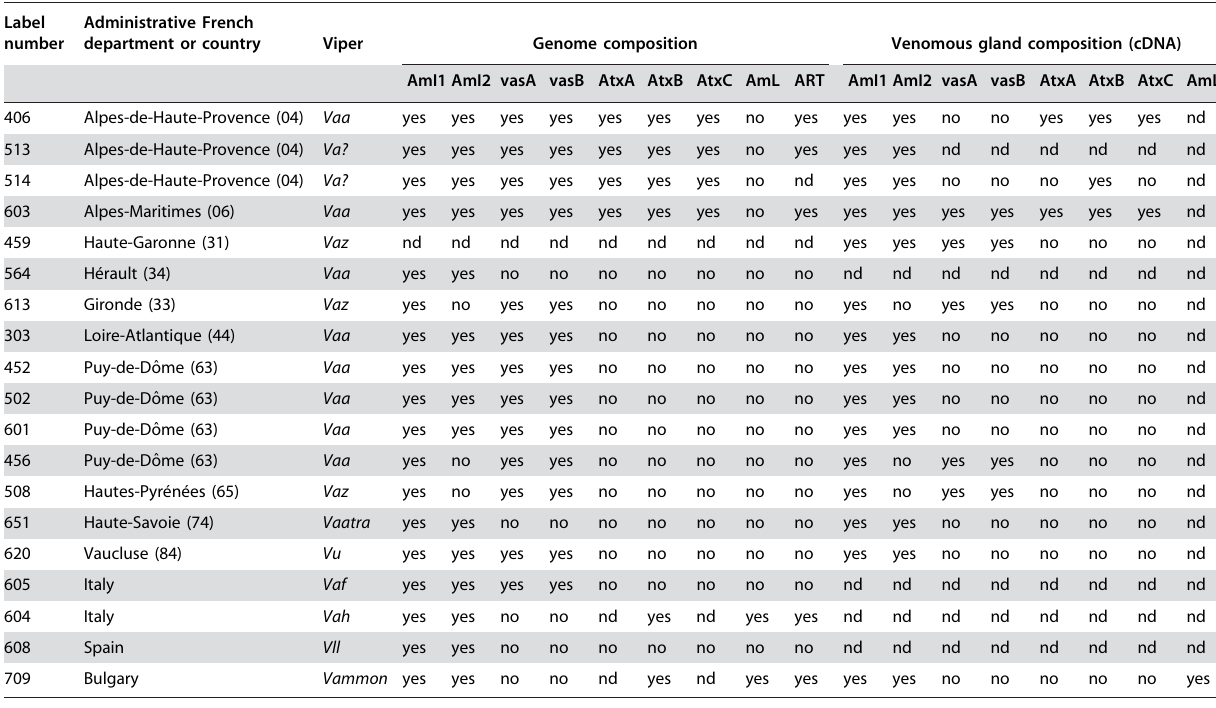
Table 2. Genome and transcriptome analysis of snake venom PLA 2 .. ... .... ... ... .... ... ... .... ... ... .... ... ... .... ... ... .... ... ... .... ... ... .... ... ... .... ... ... .... ... ... .... ... ... .... ... ... .... ... ... .... ... ... . Label Administrative French number department or country Viper Genome composition Venomous gland composition